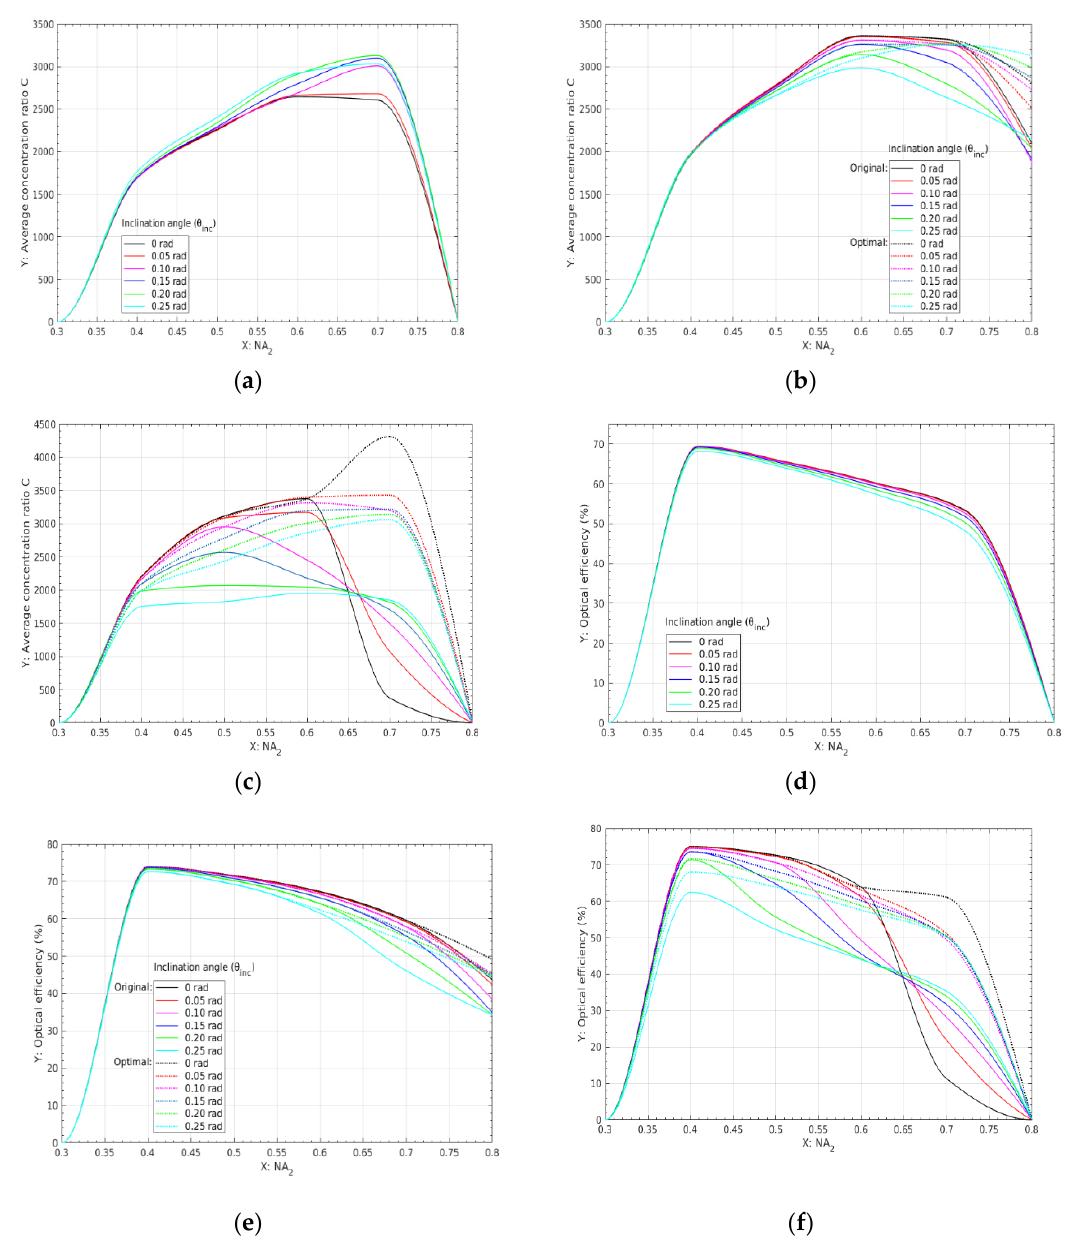
Figure 9. Results of concentration ratio ( C ) ( a ‒ c ) and optical efficiency ( η ) ( d ‒ f ) vs the field angle of the primary mirror (PM) ( = arcsin 0.8, π / 2, π − arcsin 0.8 rads) corresponding to original and optimal designs, with IF = 0.9, D = 6000 mm.